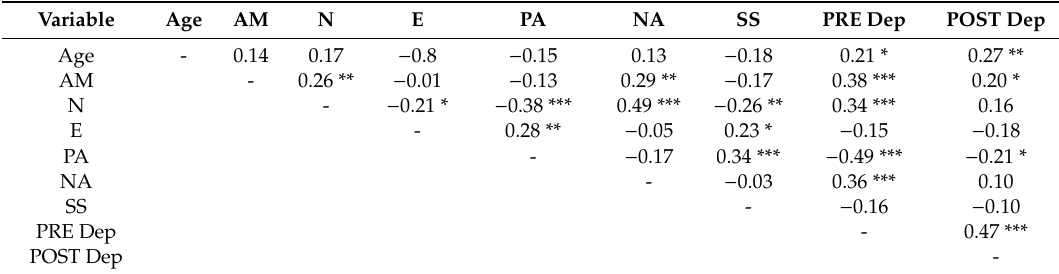
Table 4. Bivariate correlations between psychosocial variables and depressive symptoms in the sample of